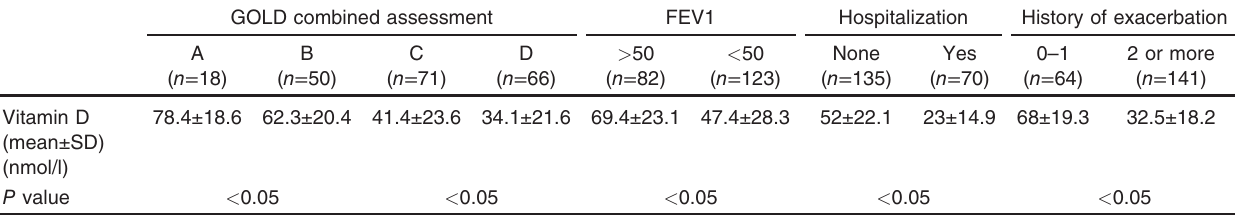
Table 3 Serum levels of 25(OH)D in nmol/l and differences with GOLD combined assessment classification, forced expiratory volume in first second, hospitalization, and history of previous exacerbation GOLD combined assessment